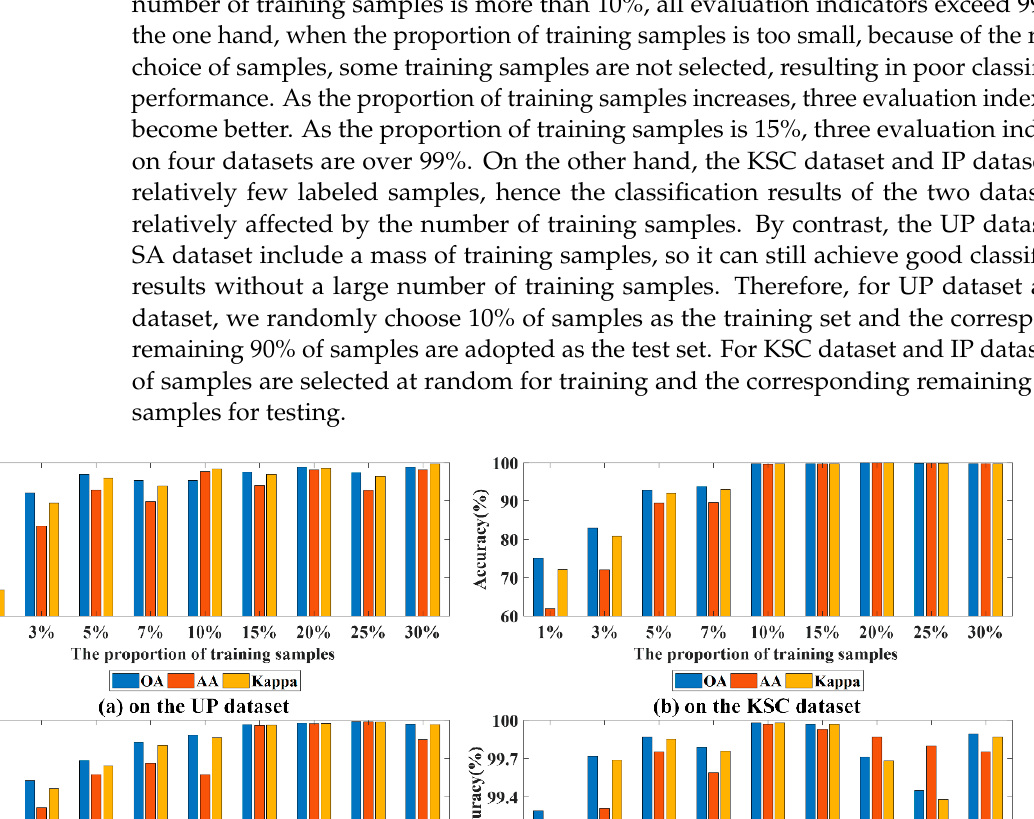
Figure 7. Three evaluation indexes for different numbers of PC on four experimental datasets.